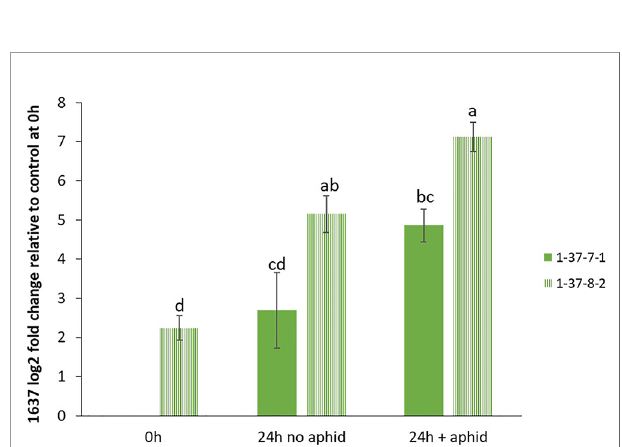
FIGURE 4 | Relative gene expression levels (mean ± SE, n=4) of b -1,3- glucanase gene 1637, expressed as fold change relative to its expression in the control line 1-37-7-1 at the start of the experiment and normalized against changes in expression level of the reference genes SF427 and Hsp70. The data were analyzed by one-way ANOVA (see Table S1 ), followed by Tukey ’ s multiple comparison test. Different letters above bars indicate signi fi cant differences between the double mutant line 1-37-8-2 and control line 1-37-7- 1 or between different treatments at p